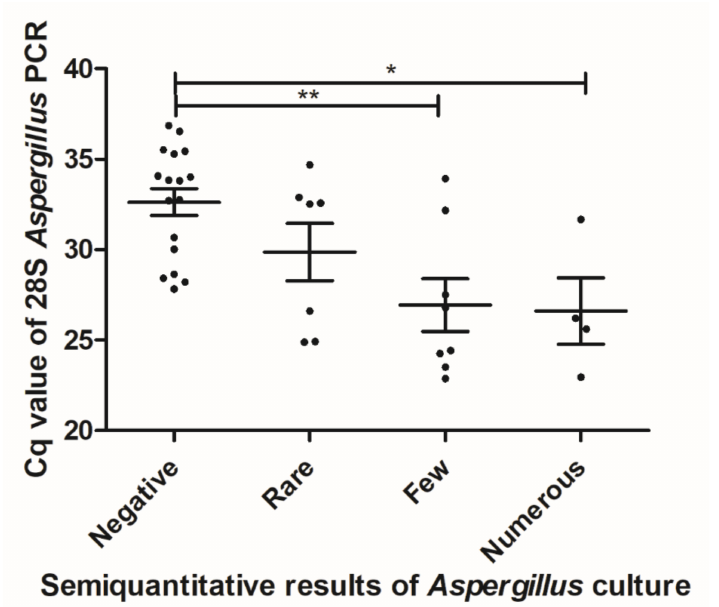
Figure 1. Correlation between molecular and cultural quantification of Aspergillus burden in respiratory samples (rare: 1–2 CFU / plate; few: 2–5; numerous: > 5). * significantly di ff erent with p < 0.05. ** significantly di ff erent with p < 0.01.